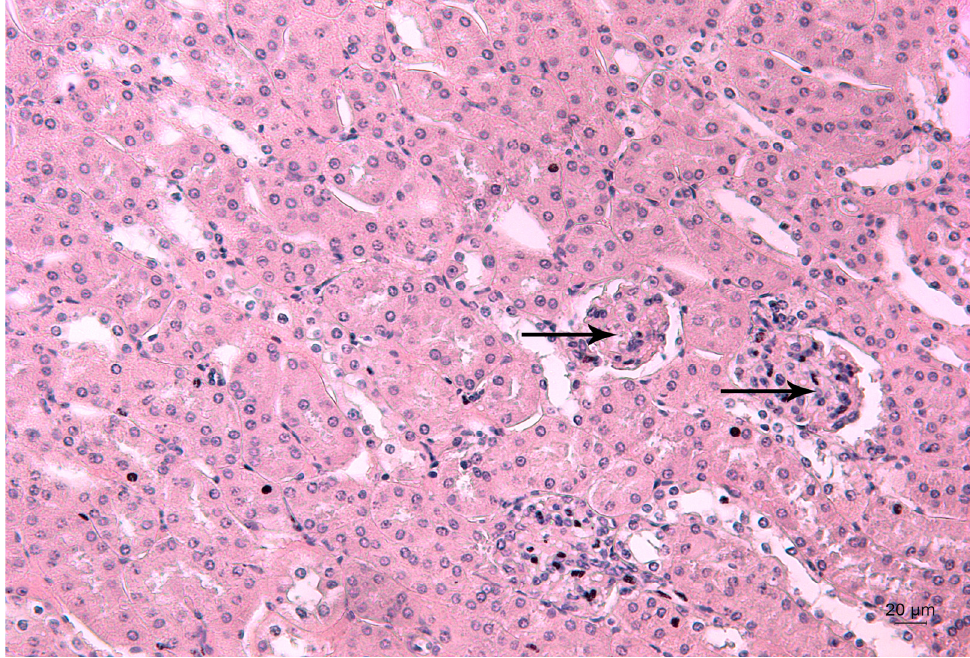
Figure 6. Representative photomicrograph of a kidney section of a Pb-exposed mouse, treated with salinomycin. Salinomycin administration resulted in a renal architecture close to that of the untreated controls. Arrows point to the renal glomeruli. HE staining, ×200.